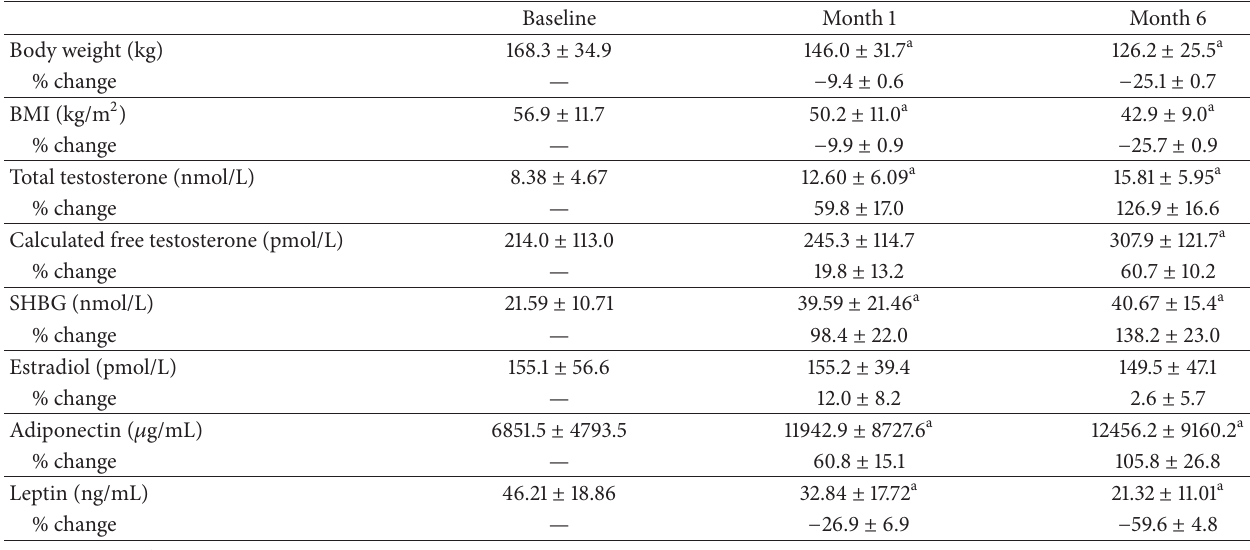
Table 2: Changes in parameters after bariatric surgery and percentage changes from baseline.